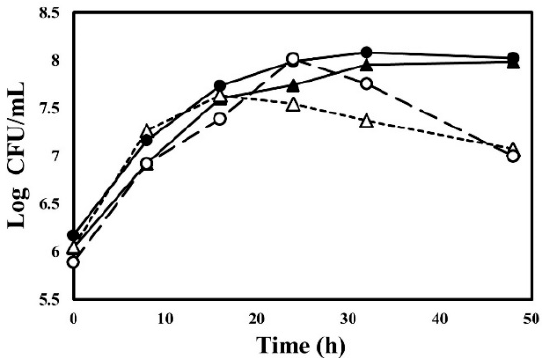
Figure 1. Change in bacterial growth over 48 h in hydroponic ginseng (HG): △ : Bacillus subtilis KU43; ● : B. subtilis KU201; ▲ : B. polyfermenticus SCD; ○ : B. polyfermenticus